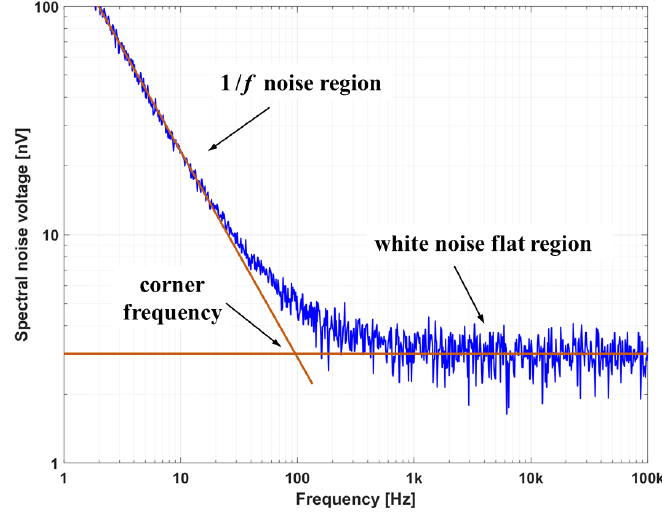
Figure 9. Typical noise in a differential